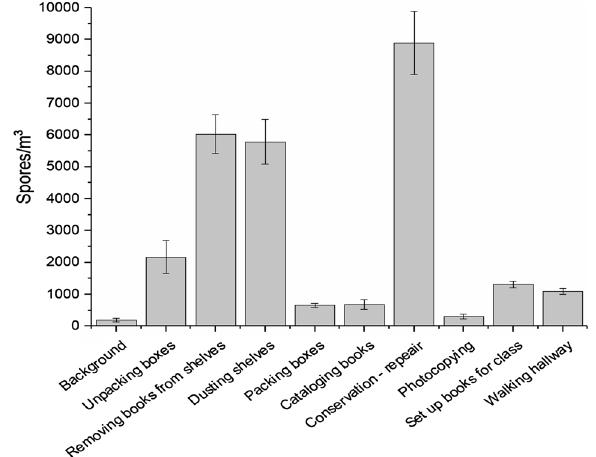
Fig. 5 Spore count per m 3 generated by each activity. Error bars are generated by the differences in the measurements obtained in dif- ferent locations and in repeated activities. The exposure limits to mold spores are not shown in the plot because set at 10 5 spore/m